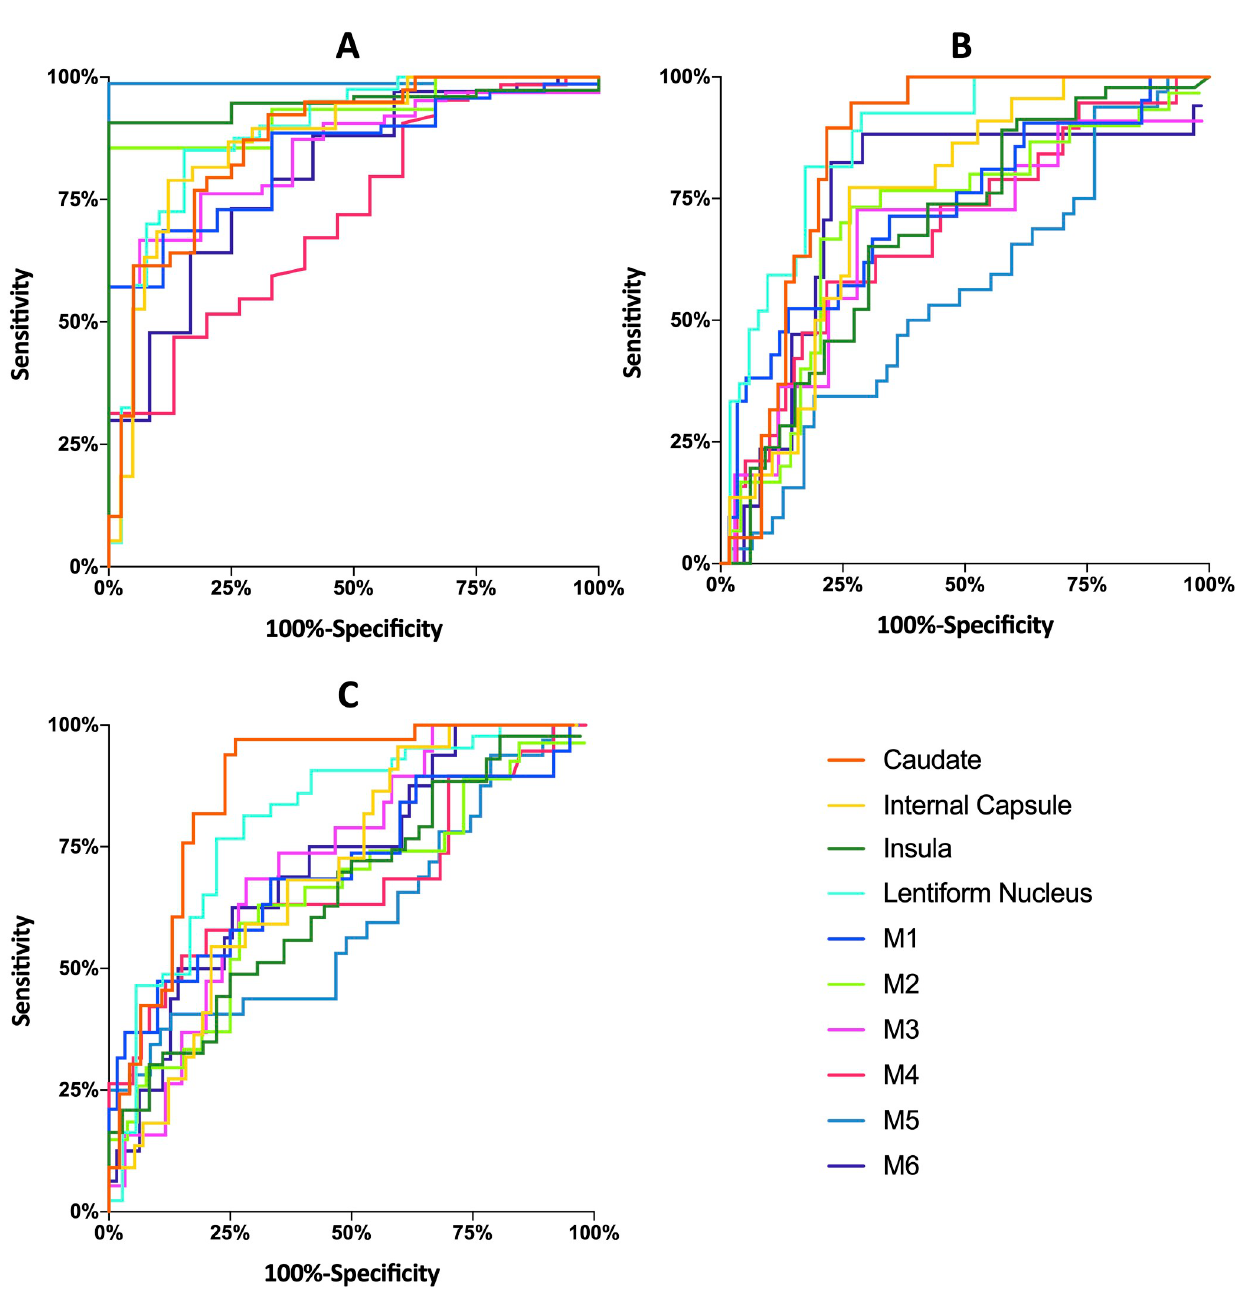
Fig 4. Receiver operating characteristic curves for classification of (A) CT perfusion-based ischemia, (B) CT perfusion-based ischemic core and (C) regional final infarction by CTASI-rHU for all Alberta Stroke Program Early CT Score regions. Abbreviations: M1-M6, M1-6 Cortices of the Alberta Stroke Program Early CT Score; CTP, CT perfusion; CTASI, CT angiography source images; rHU, relative Hounsfield